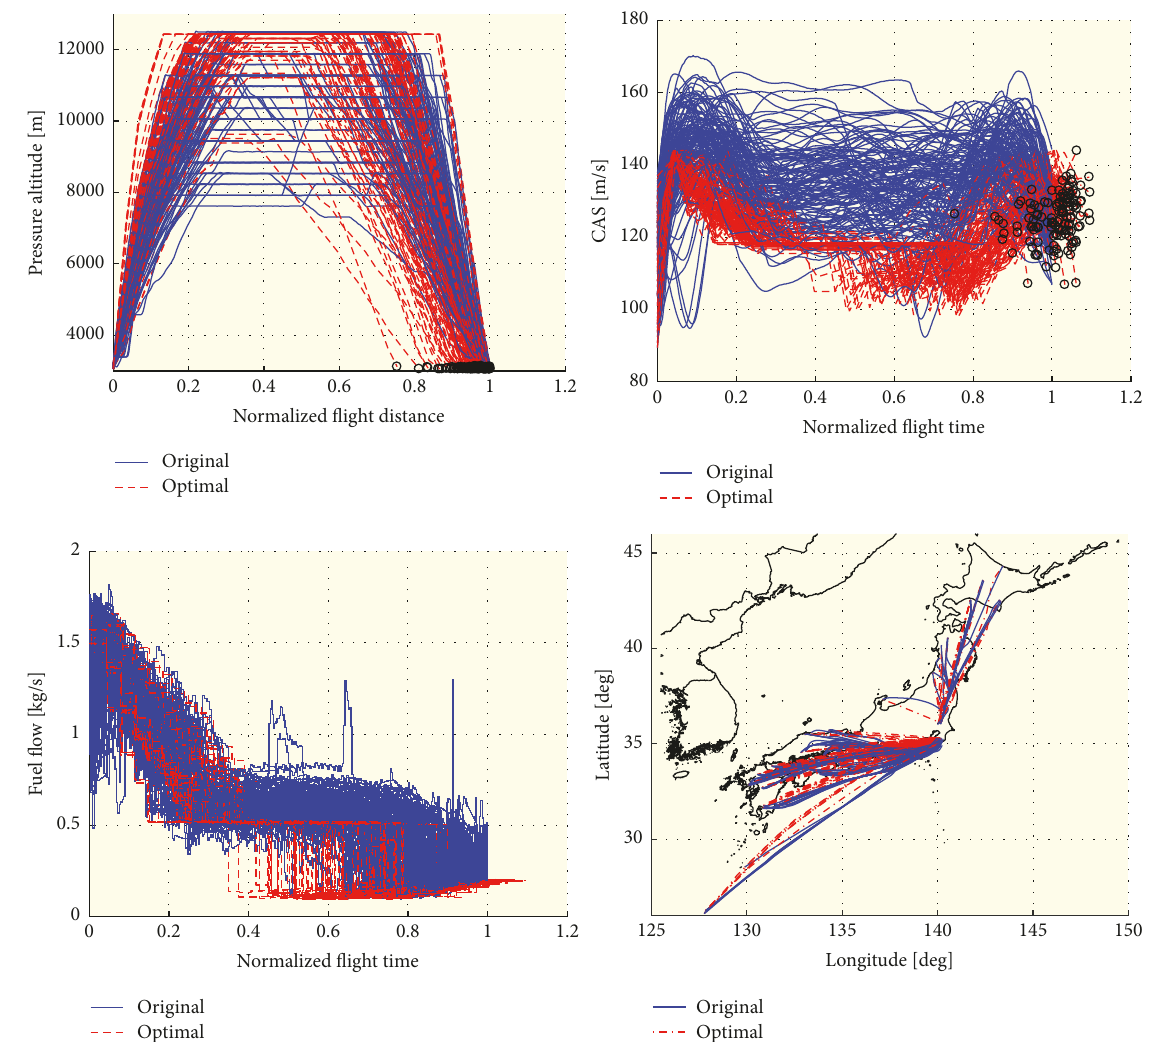
Figure 11: Pressure altitude, CAS, fuel flow, and flight path of the original and optimal arrival flights to Haneda Airport.